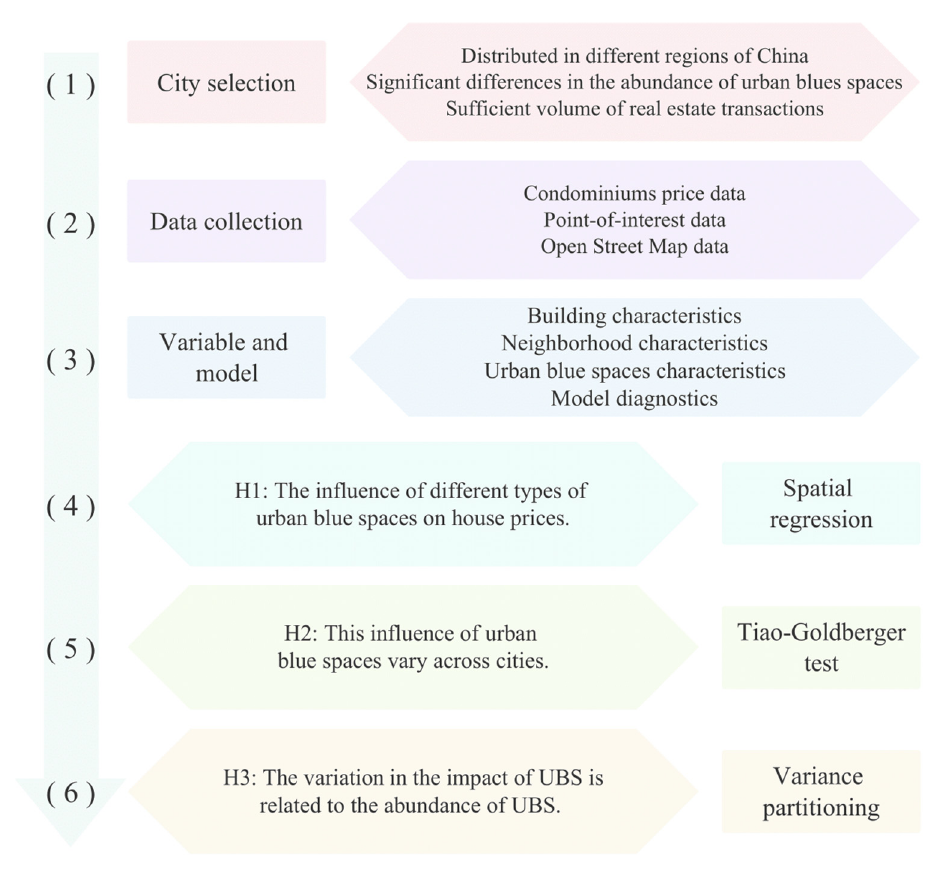
Figure 1. General methodological flow.